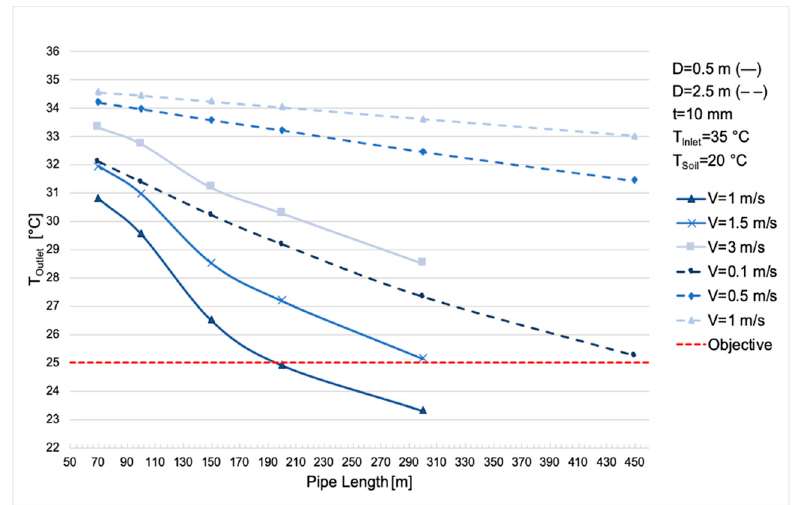
Figure 5. Variation of the outlet air temperature with pipe length and air velocity for D P = 0.5 m and D P = 2.5 m.